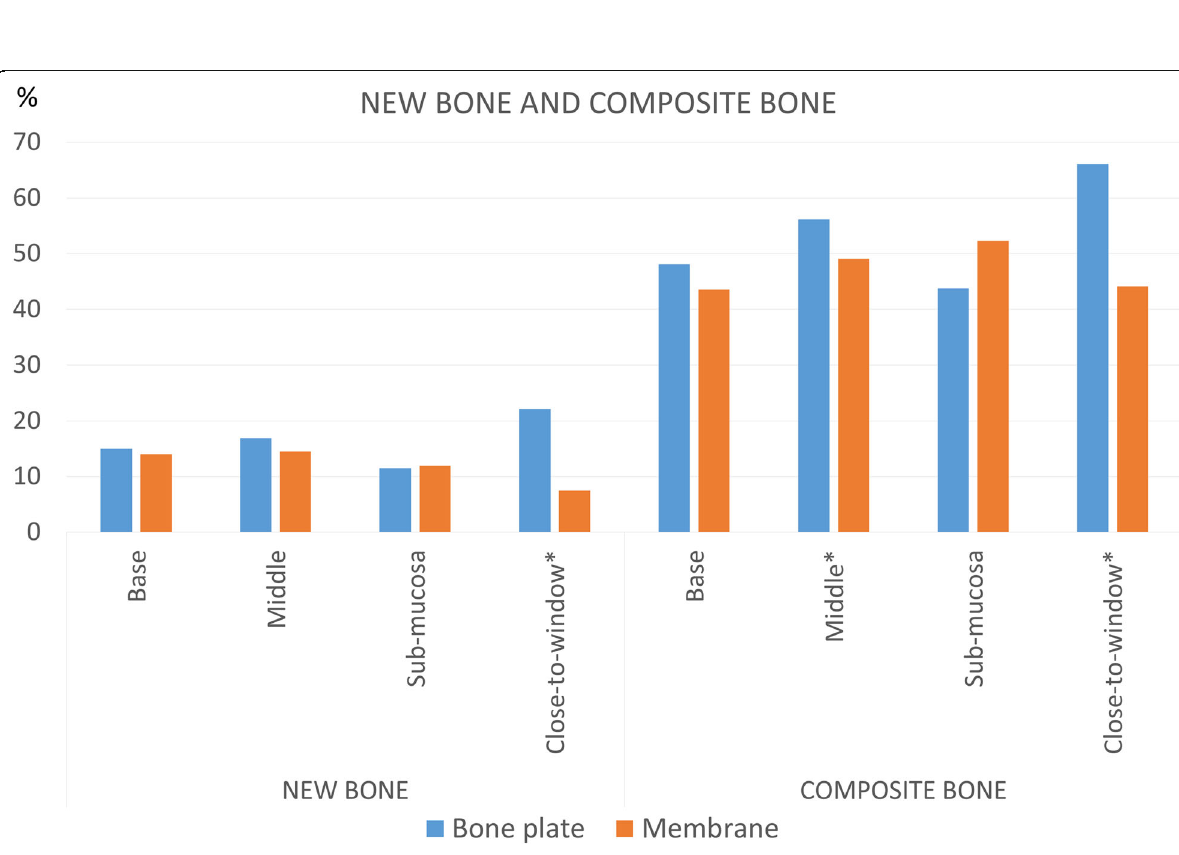
Fig. 6 Graph representing new bone and composite bone percentages within the elevated